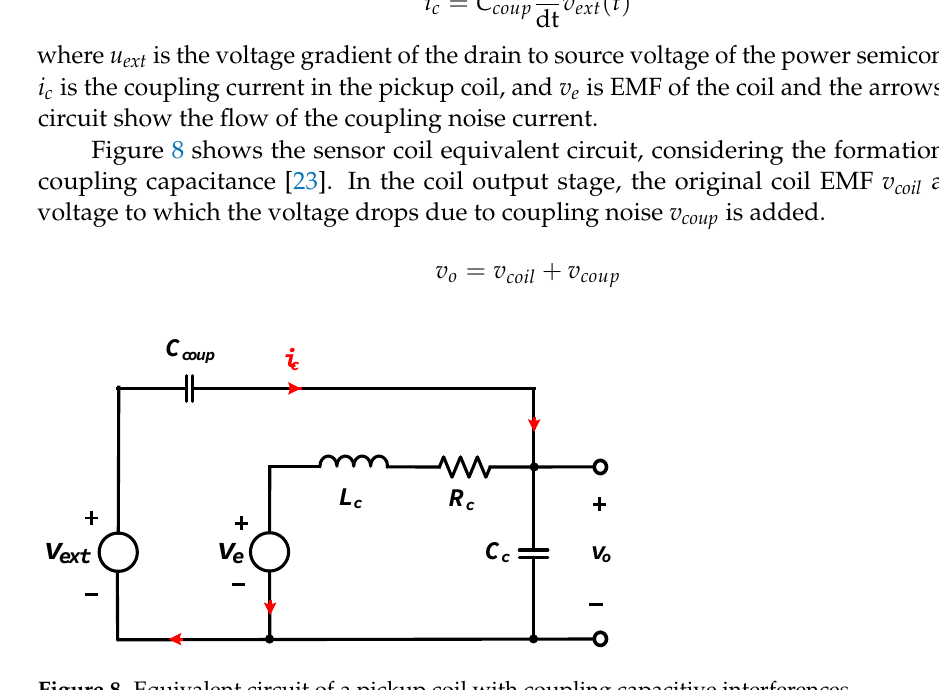
Figure 8. Equivalent circuit of a pickup coil with coupling capacitive interferences.